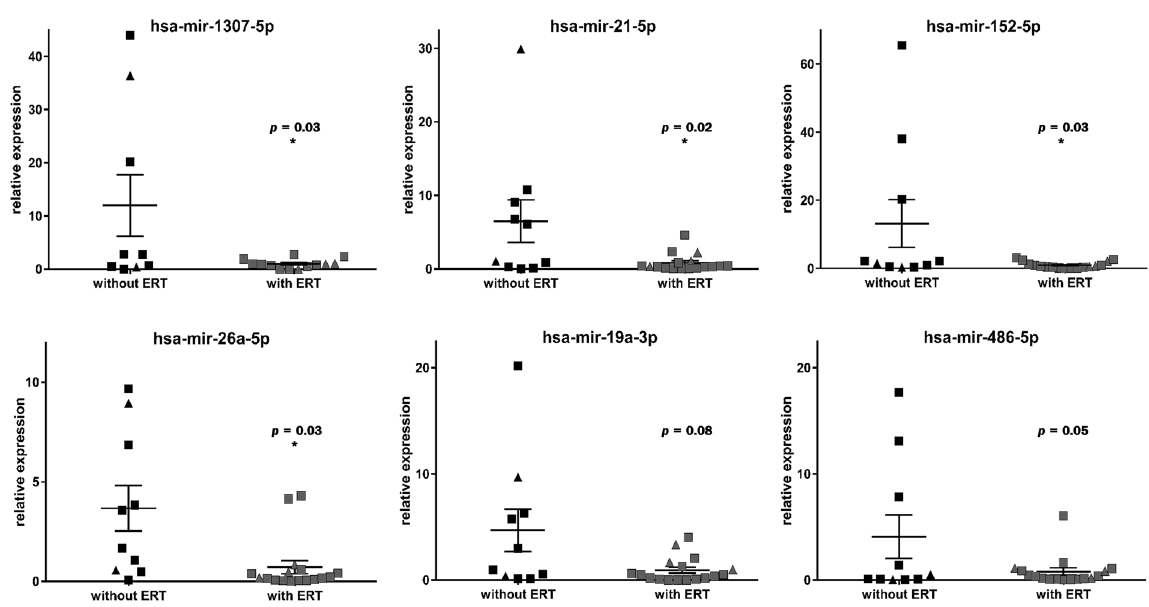
Figure 3. Validation of miRNA candidates in serum of Fabry patients. Illustration of the relative expression of miRNA candidates validated in serum samples of Fabry patients by RT-qPCR. Data from female patients and male patients are presented by triangles and squares, respectively. * p <